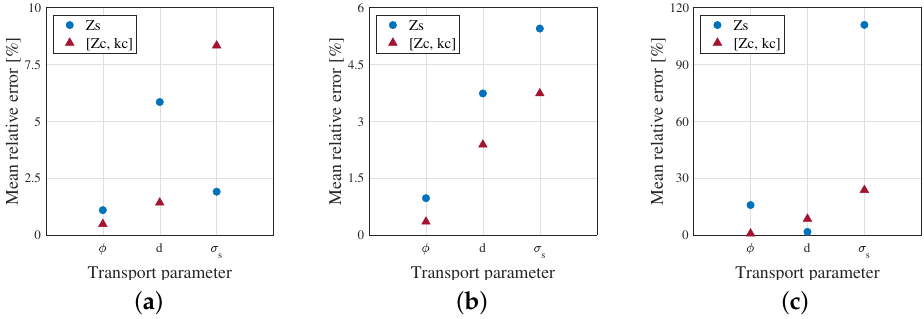
Figure 8. Comparison of the mean relative error of transport parameters identified from the sur- face impedance Z s and two acoustic properties [ Z c , k c ] for three generated samples, ( a ) Sample A, ( b ) Sample B, ( c ) Sample